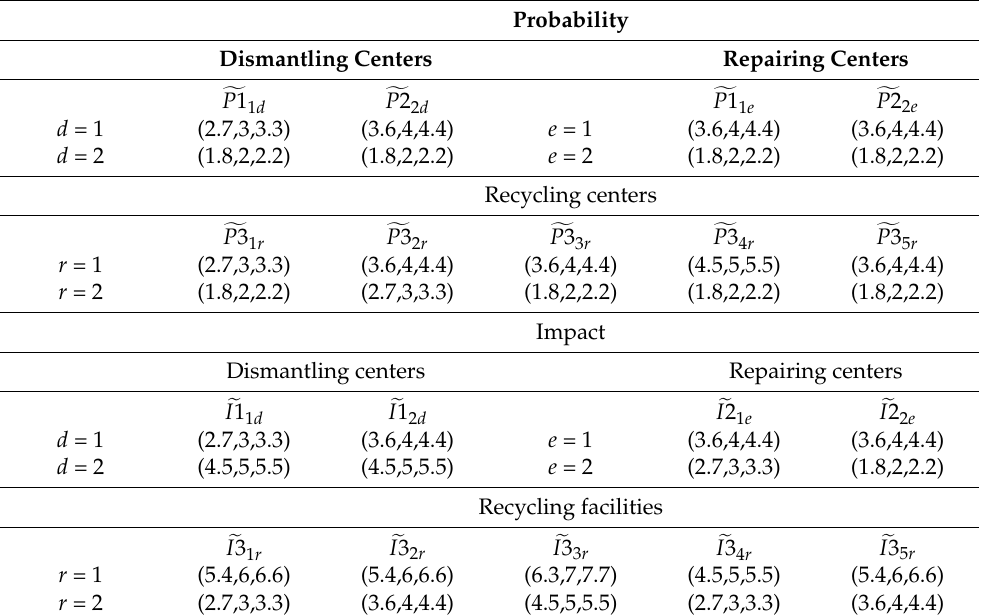
Table 14. Probability of accident occurrence and the impact at dismantling, repairing, and recycling